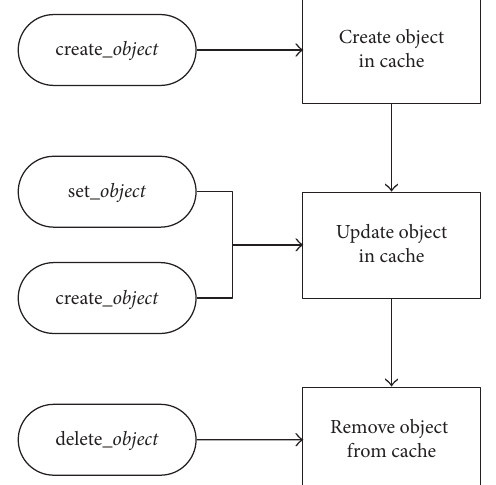
Figure 4: The life cycle of X23 objects in the object cache. Object creation is triggered by create object messages, attributes are updated according to set object messages, and objects deletion is finally caused by delete object messages. As optimization cached objects may also be updated by create object